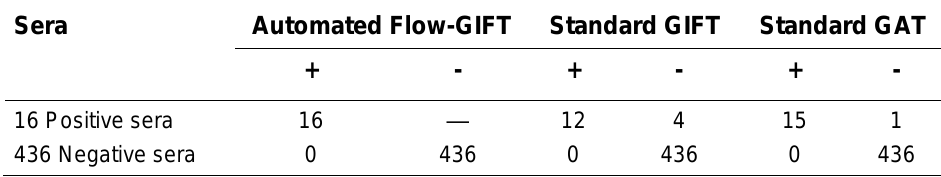
Investigation of 452 Sera Sera Automated Flow-GIFT Standard GIFT Standard GAT + - + - + - 16 Positive sera 16 — 12 4 15 1 436 Negative sera 0 436 0 436 0